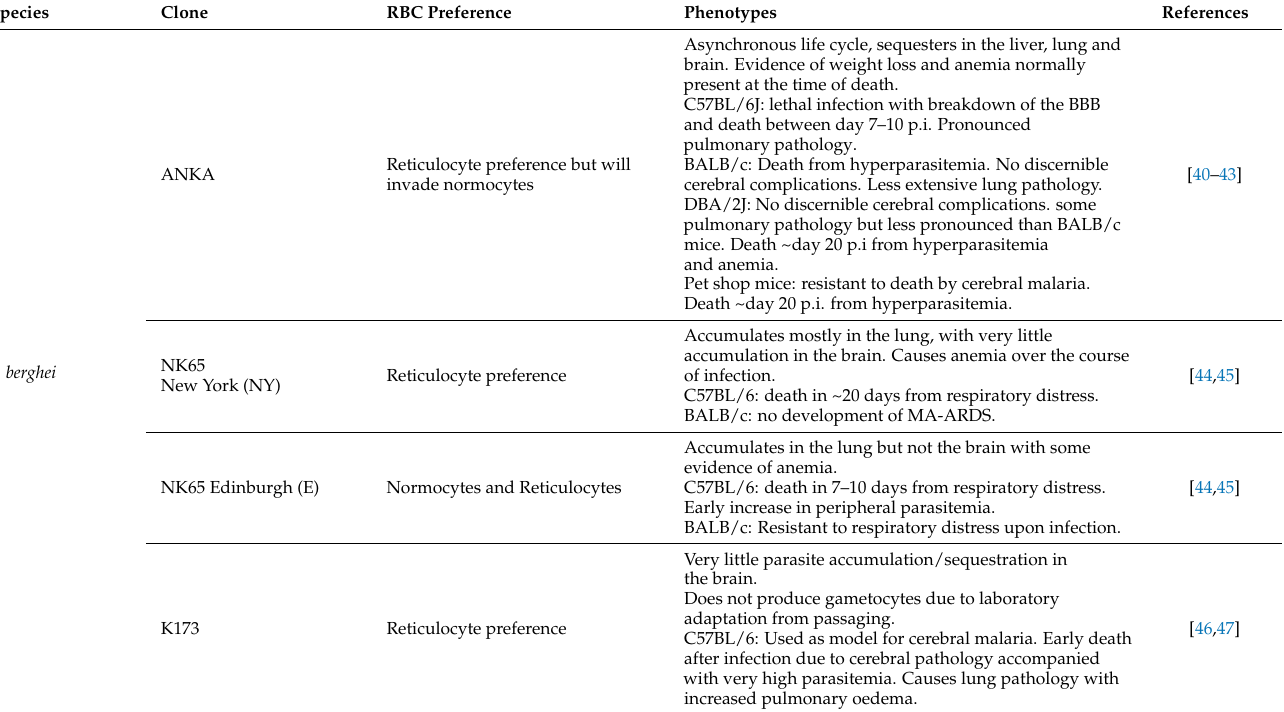
Table 2. Disease phenotype and pathophysiology of the main rodent Plasmodium species used in biomedical